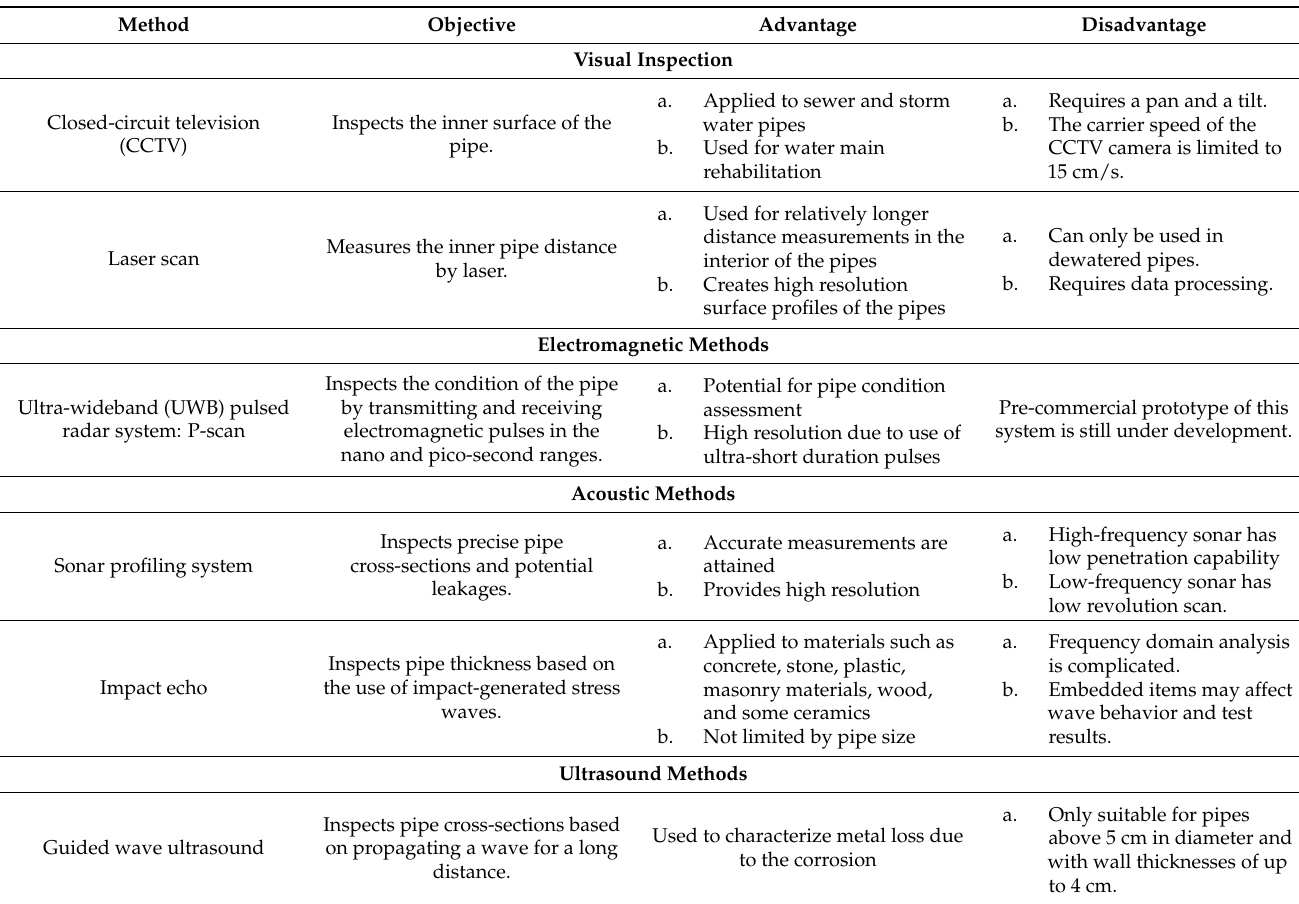
Table 1. Non-destructive techniques adapted from Liu and Kleiner